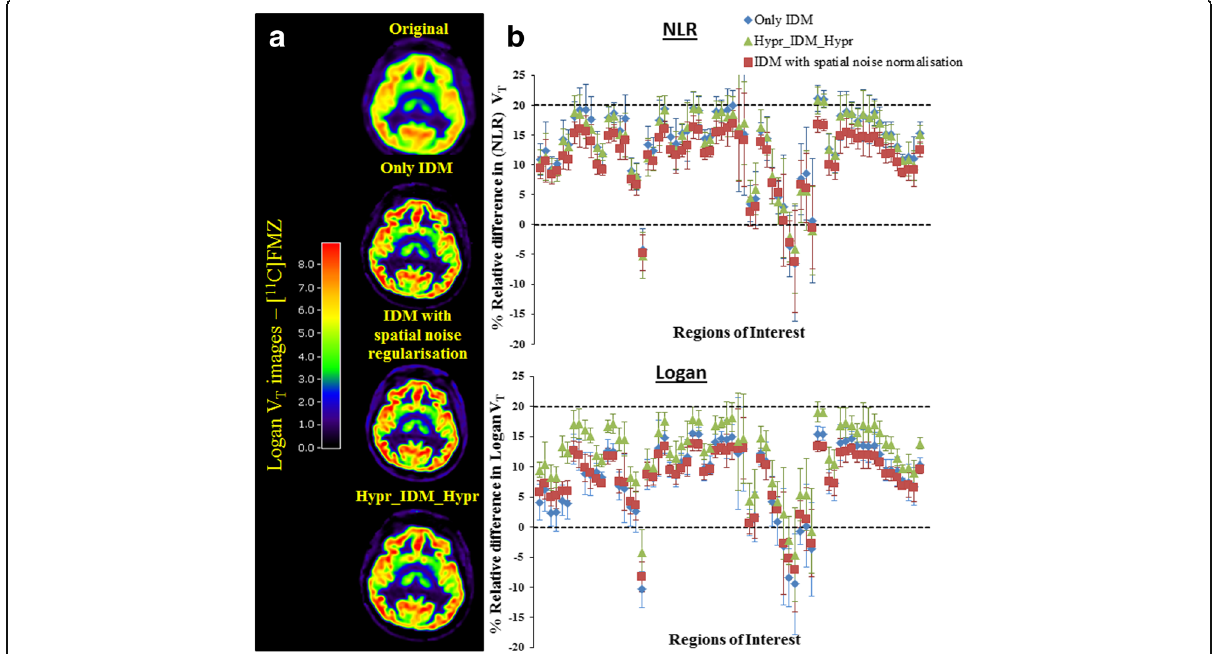
Fig. 5 a Typical [ 11 C]FMZ V T images obtained using Logan analyses. b Quantitative effect of applying IDM on V T values obtained using Logan and